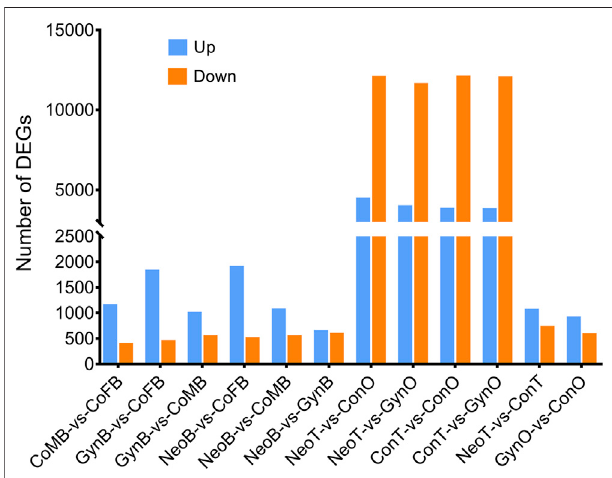
FIGURE 3 | Comparison of differentially expressed gene (DEG) numbers.